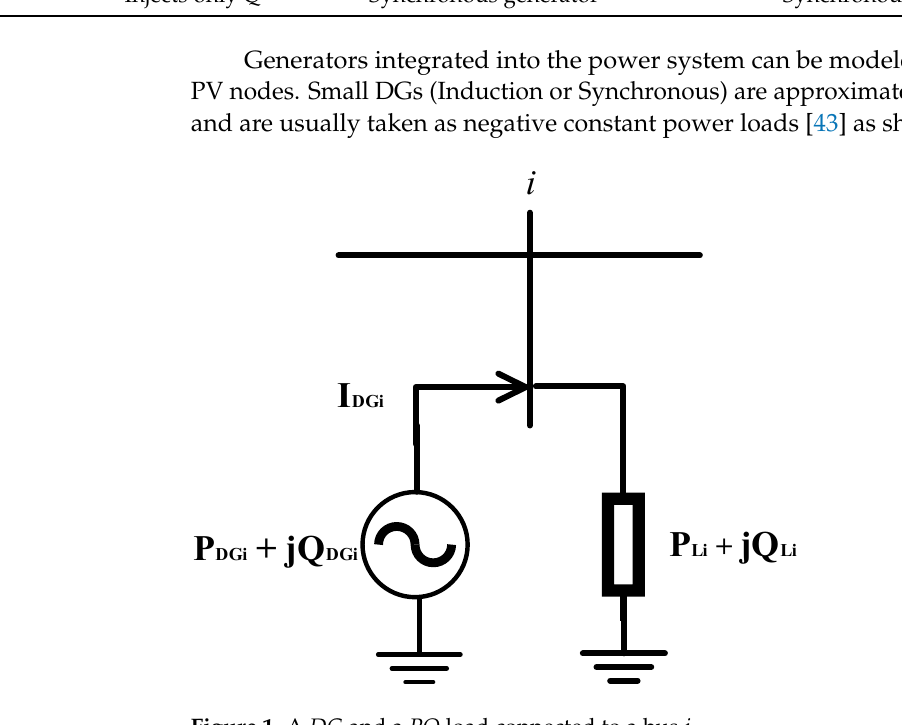
Figure 1. A DG and a PQ load connected to a bus i .